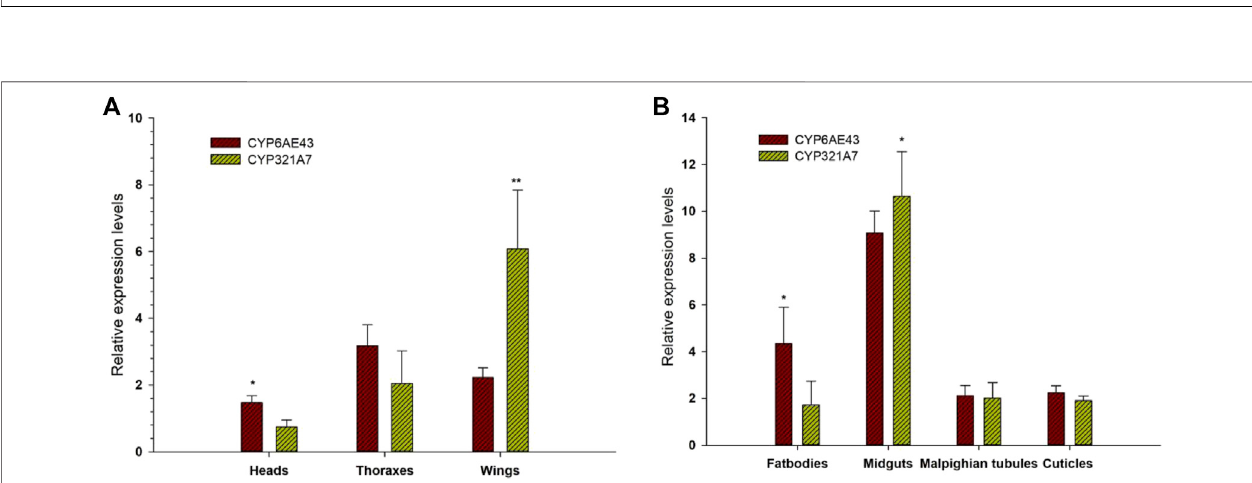
FIGURE 2 | Midgut expression pro fi les of CYP4-clade (A) , CYP3-clade (B) , CYP2-clade (C) and Mito-clade (D) from S. frugiperda larvae. Bars represent relative expression(mean±SE).Allbiologicalgroupscontainedthreereplicatesforeachtreatment,andtherewerethreetechnicalreplicates.ThetranscriptionlevelsofallP450s genes determined by quantitative real-time PCR, normalized to two reference genes. The data were expressed as the means ± SE. The bars with astriks indicate signi fi cant differences within the same treatment at the p < 0.05 level, based on Student ’ s t test.